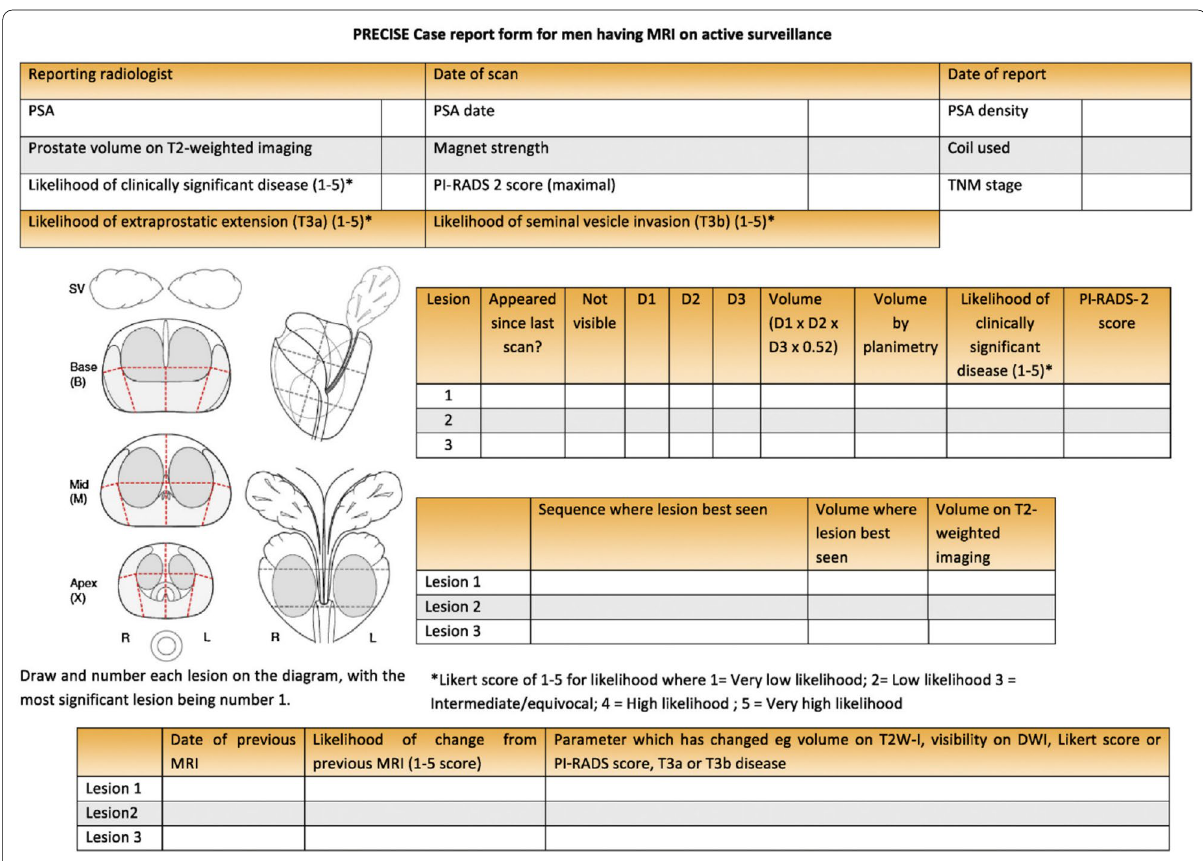
Fig. 5 PRECISE case report form